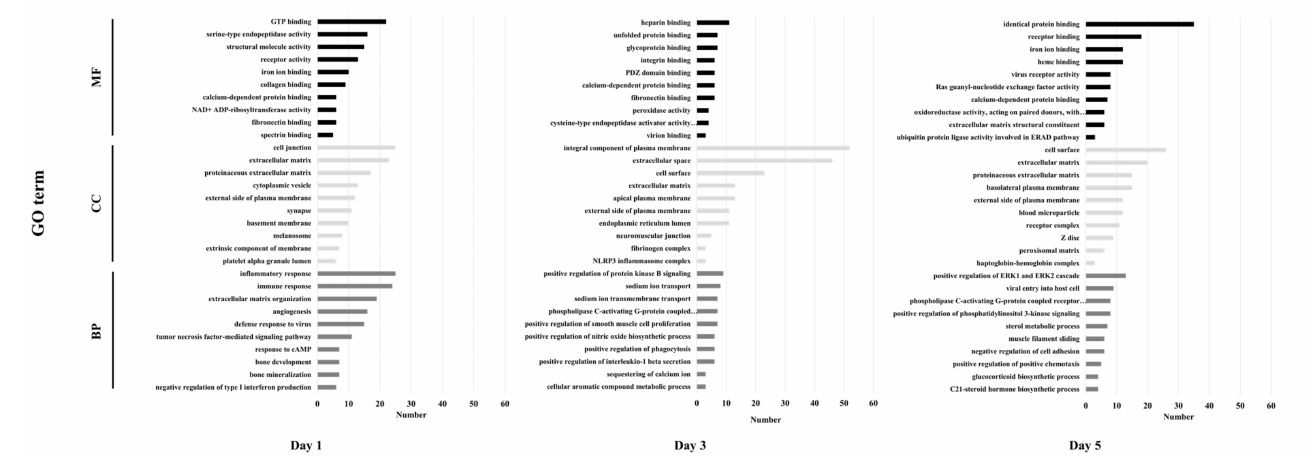
Figure 2. GO functional classification of DEGs between PBS and AV groups at days 1, 3, and 5. DEGs were annotated by biological process, cellular component, and molecular function. The X-axis is the number of annotated DEGs, and the Y-axis is the top 10 GO